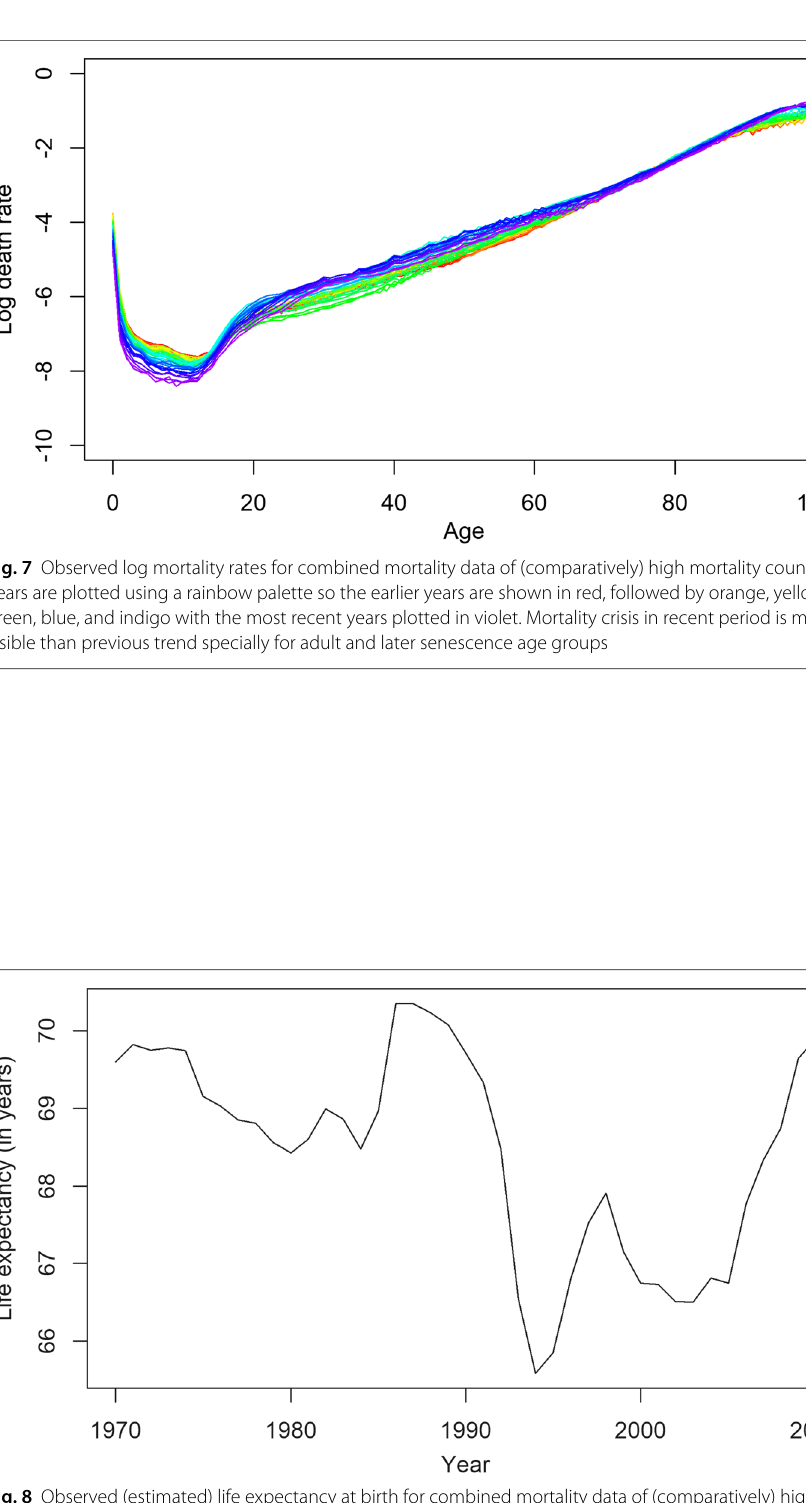
Fig. 8 Observed (estimated) life expectancy at birth for combined mortality data of (comparatively) high mortality countries